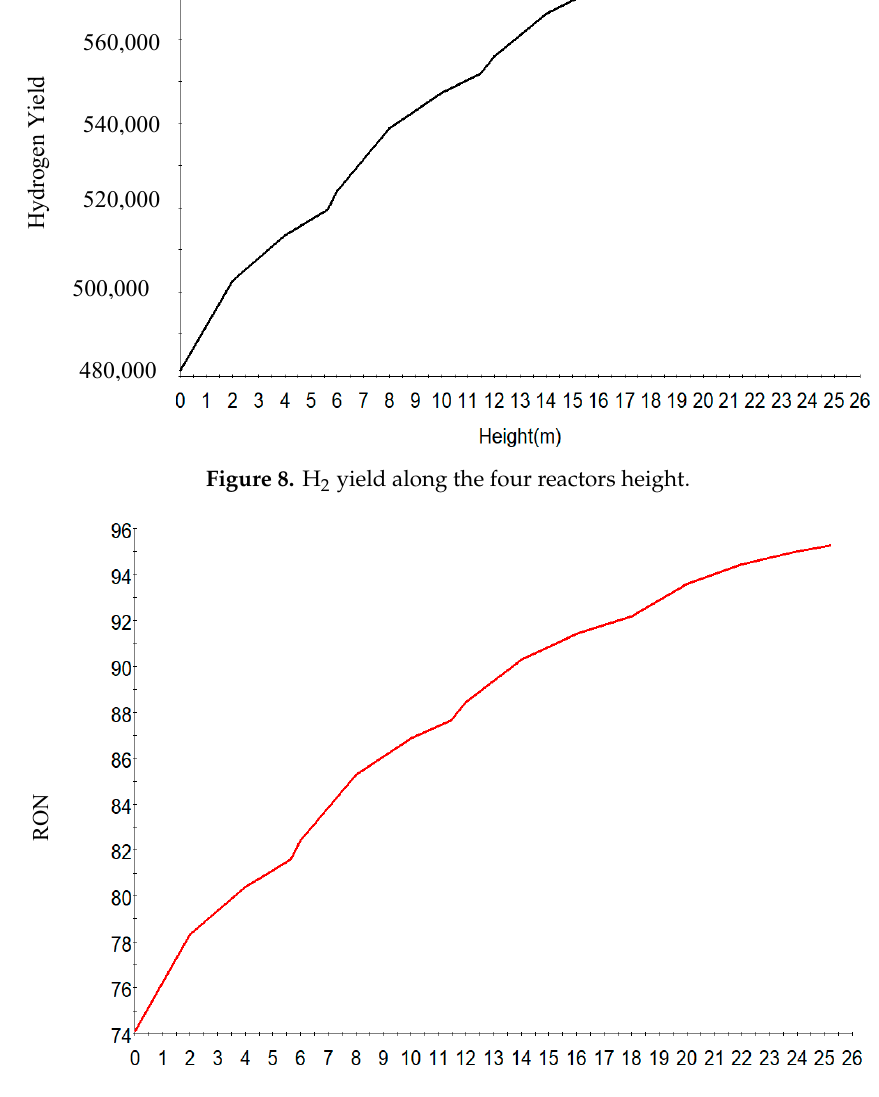
Figure 9. RON along the reactor height.